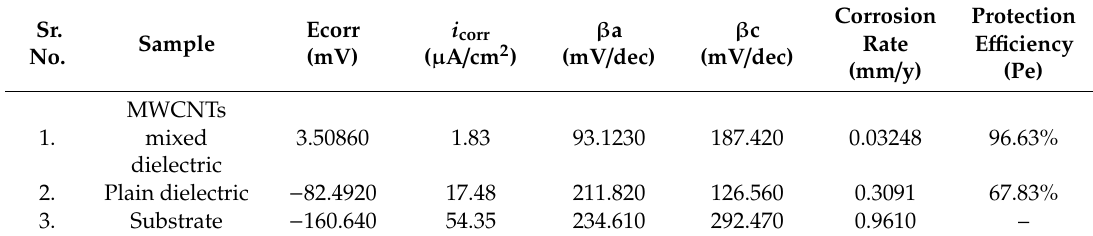
Table 8. Polarization corrosion data of specimens in Ringer solution at 37 ◦